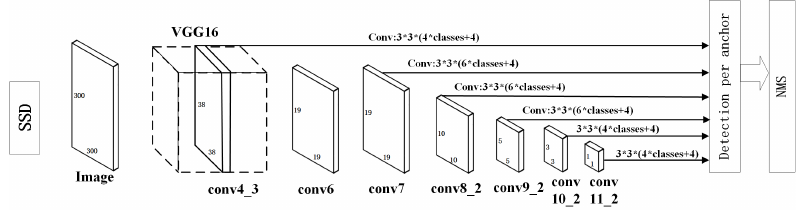
Figure 1. Network-structure diagram of traditional SSD